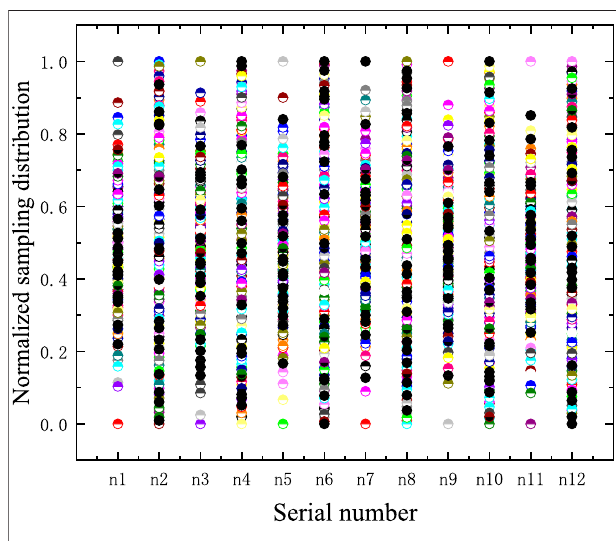
FIGURE 5 | Normalized distribution of Latin hypercube